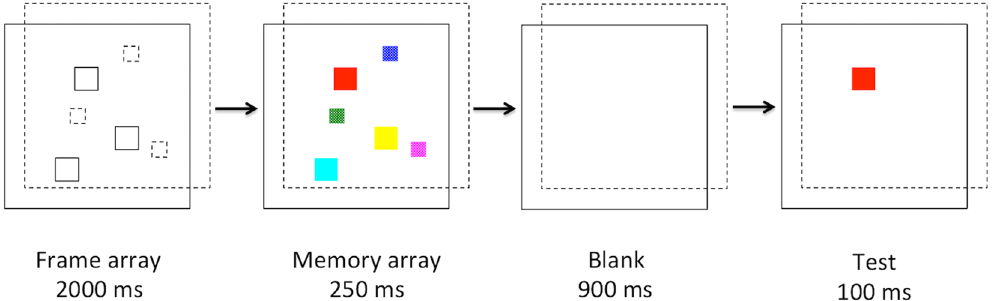
Figure 4. The task sequences in Experiment 3. Half of the items were of a large size at the front depth plane, and half of a small size at the back plane. The frames with solid lines indicates the front plane, the frames with dashed lines indicates the back plane. The frame lines were all solid in the formal experiments.